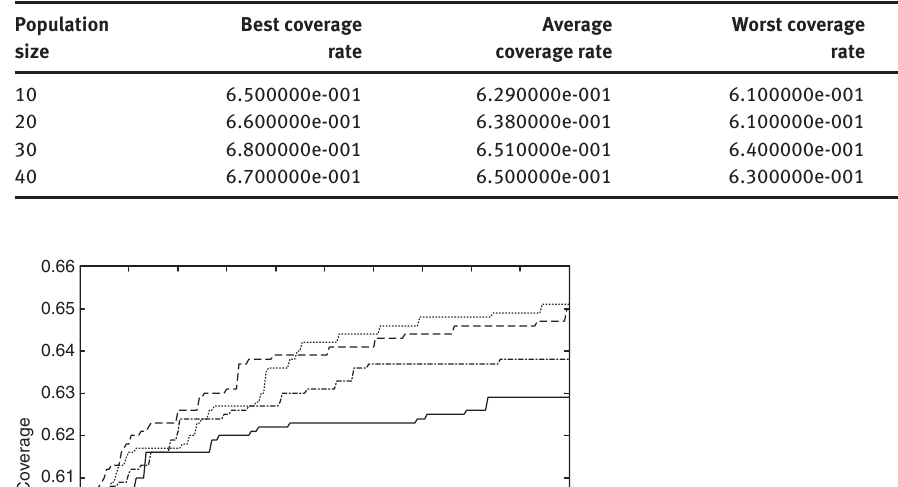
Table 1: The Statistical Results about the Influence of the Population Size on Coverage Performance.